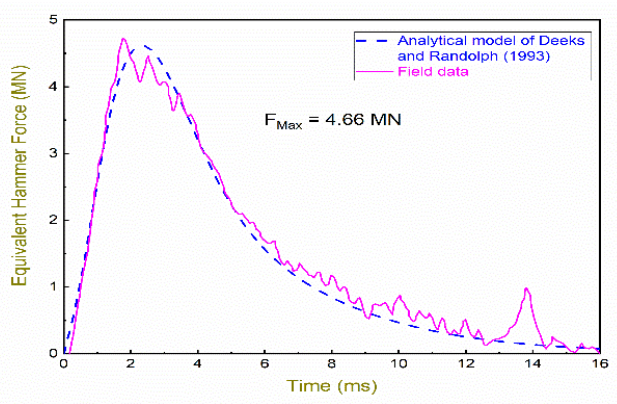
Figure 4. Impact force hammer BSP 357 versus time.